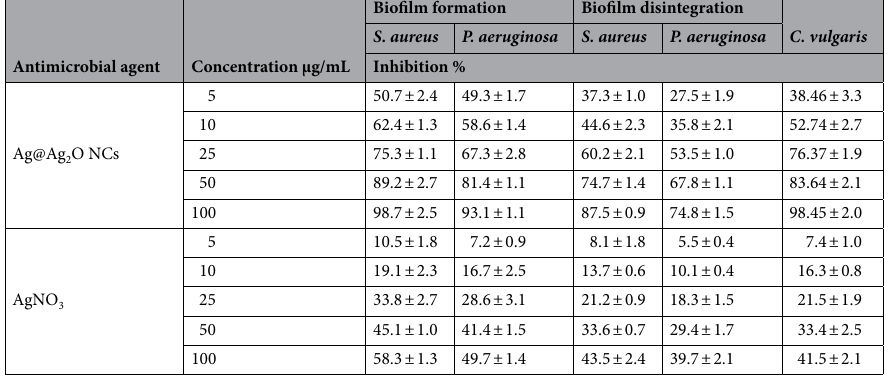
Table 1. Biocide activity of Ag@Ag 2 O NCson bio-film formation, biofilm disintegration and algal